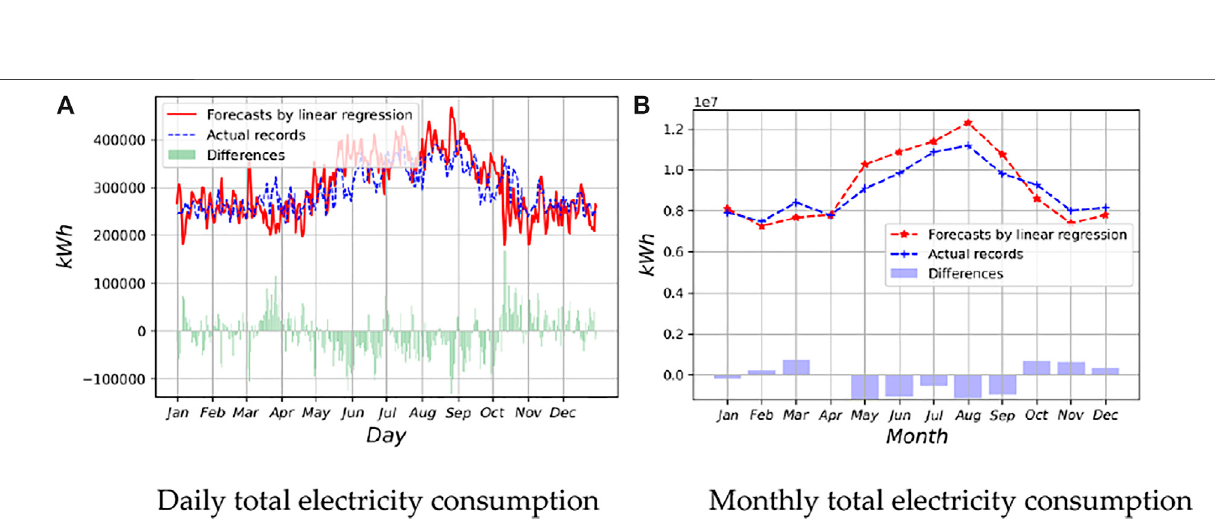
Frontiers in Energy Research |